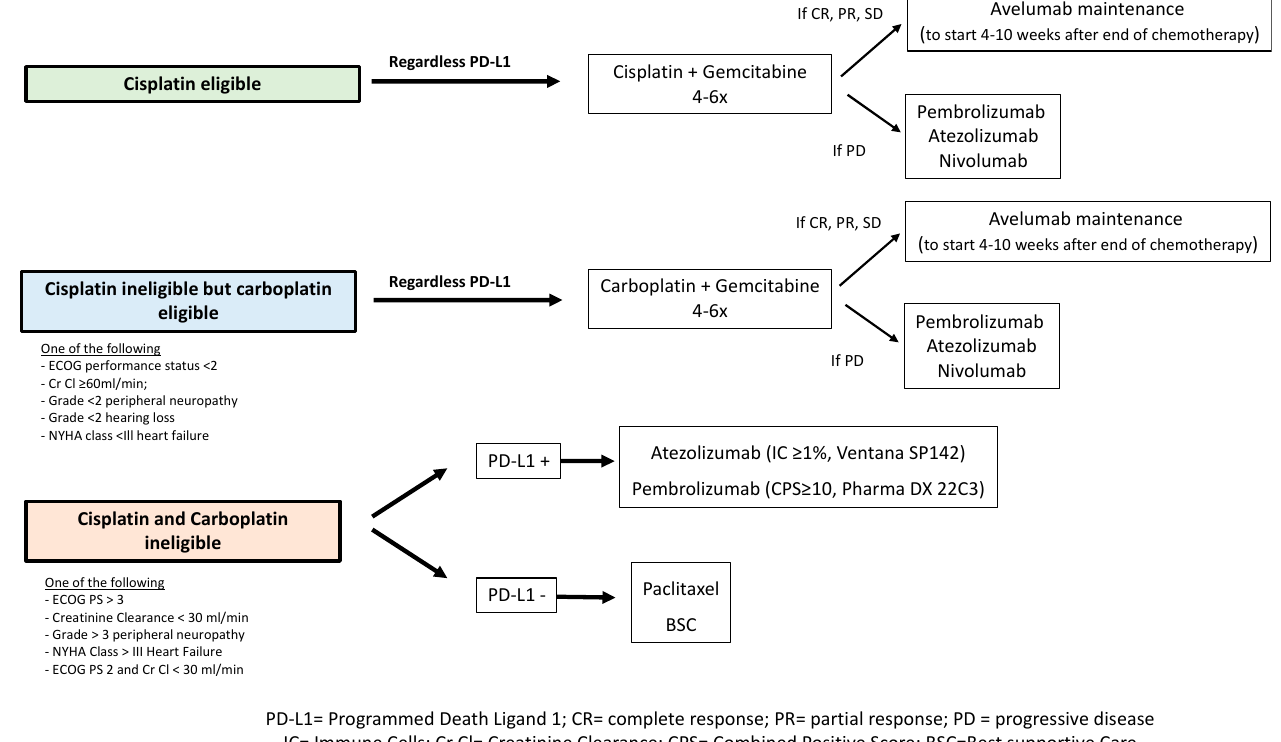
Figure 3. Current management of metastatic UC in a first ‐ line setting.